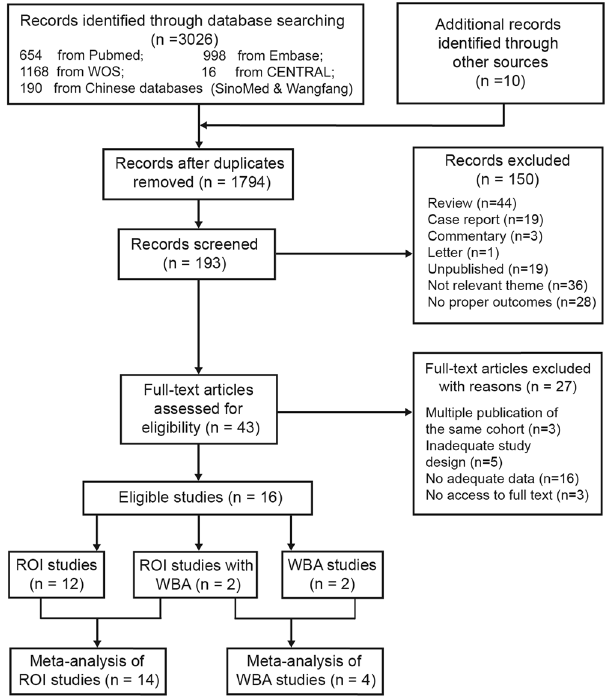
Figure 1. Flow diagram of the inclusion and exclusion of studies. ROI: region of interest; WBA: whole brain